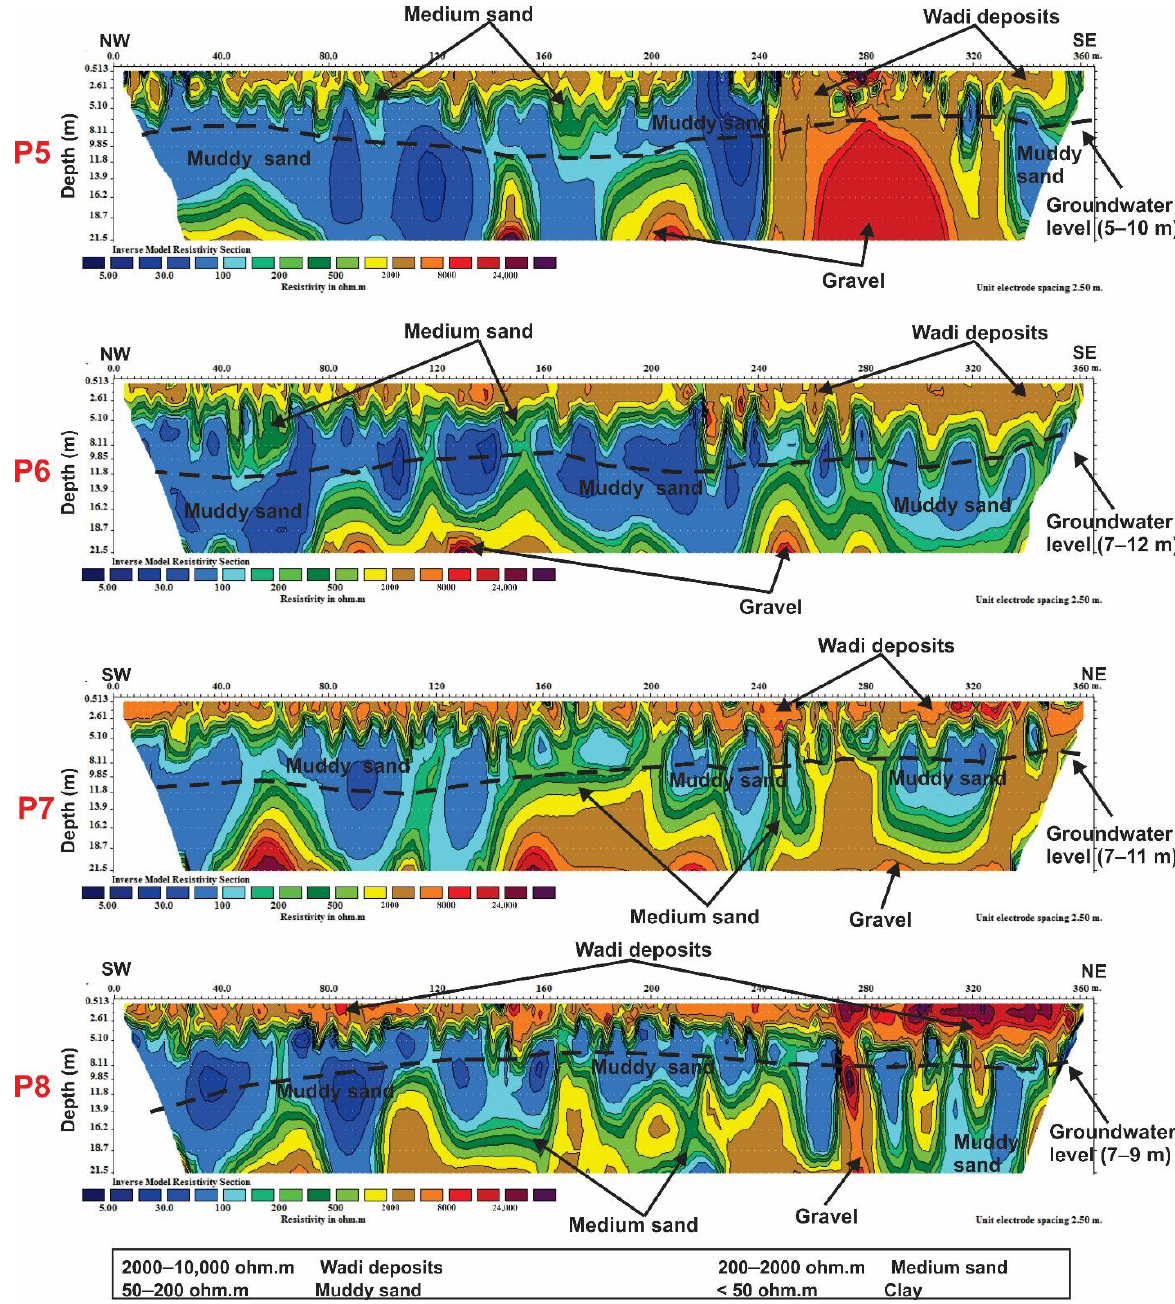
Figure 6. Interpreted 2D inverted resistivity model of profiles 5–8. According to the resistivity values, four difference geoelectric zones were recognized. These zones are: (1) wadi deposits, which are mainly composed of gravels, sands, and silts; (2) medium sand deposits; (3) muddy sand deposits; and (4) clay deposits.